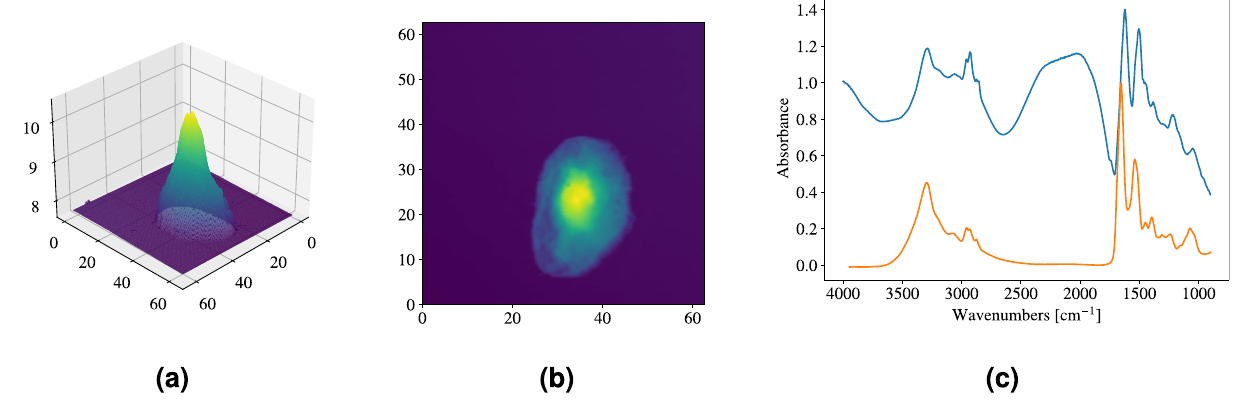
Figure 2. Properties of a lung-cancer cell. ( a ) AFM height map showing its 3D topography, which resembles a dome. ( b ) 2D contour heat map showing the same information as ( a ), but in 2D cross sectional information is brought out more clearly. ( c ) Infrared spectrum of the lung-cancer cell 15,27 (blue line), containing Mie-scattering contributions, compared with a pure Matrigel absorbance spectrum (orange line), approximately representative of a human cell, devoid of any Mie-scattering